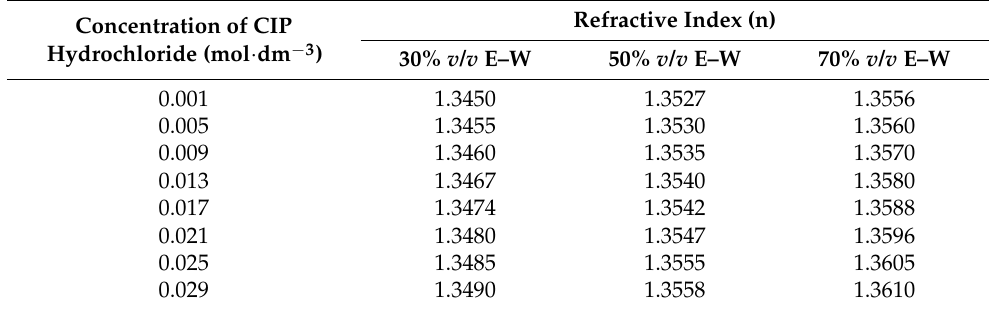
Table 1. RI Values of CIP hydrochloride solutions for various concentrations and compositions [59]. Concentration of CIP Hydrochloride (mol · dm − 3 )